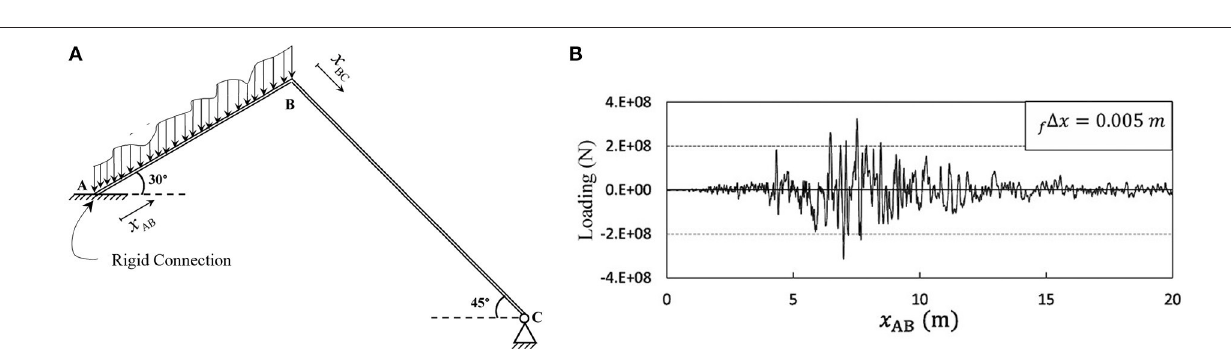
FIGURE 4 | Structural system in the second example (A) structural model and (B) loading.